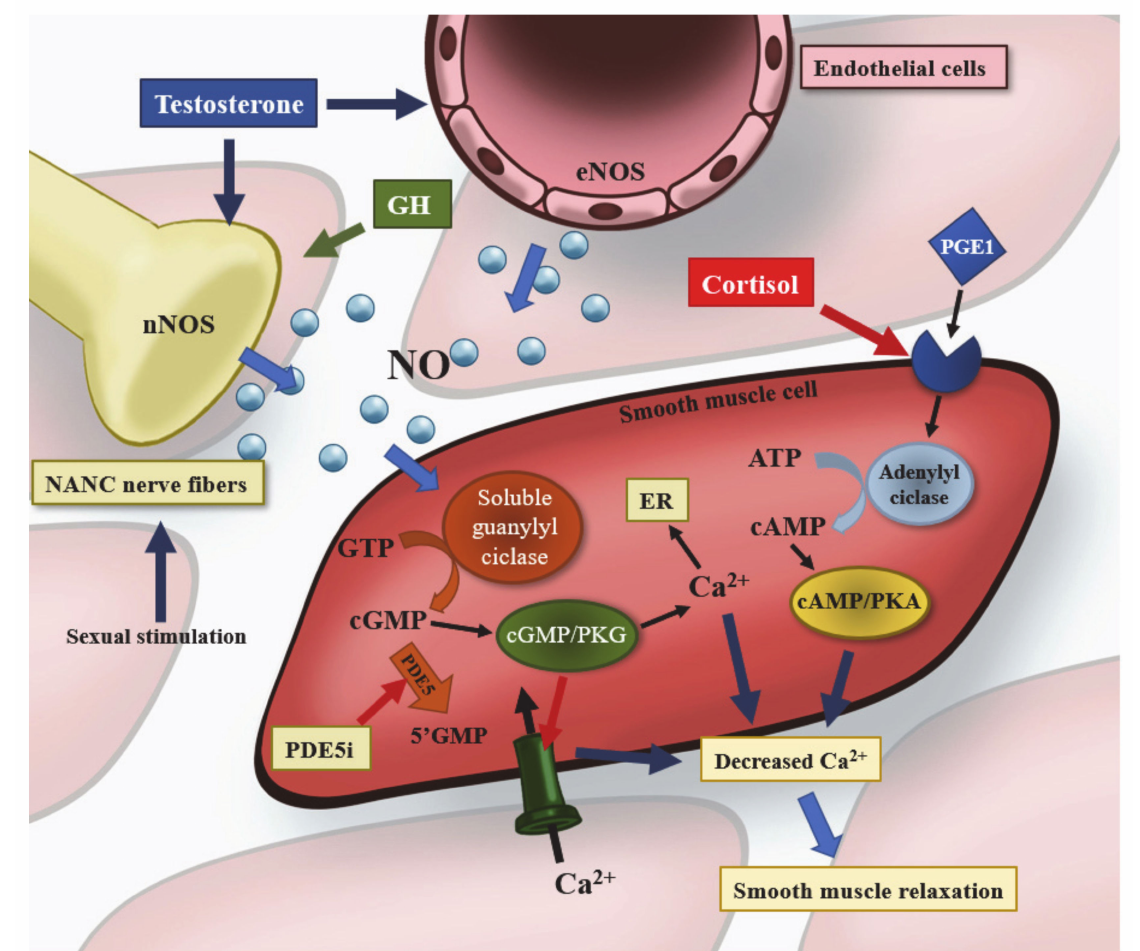
Figure 1. Mechanism of penile erection and hormonal interactions. Nitric oxide (NO) is produced by the enzyme NO synthase (NOS), which is located inside nonadrenergic noncholinergic (NANC) nerves (nNOS) and endothelial cells (eNOS). Sexual stimulation triggers the release of NO by the NANC nerves, which is enhanced by growth hormone (GH) and testosterone. The latter also upregulates the activity of NOS in both nerves and endothelial cells. In penile smooth muscle cells, NO binds to soluble guanylyl ciclase to increase production of 3 (cid:48) ,5 (cid:48) -cyclic guanosine monophosphate (cGMP) from guanosine-5 (cid:48) -triphosphate (GTP), which activates protein kinase G (PKG) to form a complex cGMP/PKG, which in turn inhibits the entry of extracellular calcium and promotes the shift of intracellular calcium into the endoplasmic reticulum (ER). Decreased calcium concentration leads to smooth muscle relaxation and, consequently, dilatation of the cavernous arteries and penile erection. Activity of cGMP/PKG is physiologically limited by the enzyme phosphodiesterase 5 (PDE5), which is the target of PDE5 inhibitor drugs (PDE5i), the first line of treatment for erectile dysfunction (ED). Prostaglandin 1 (PGE1), which is administered through intracavernosal injections for the treatment of ED, binds a G-protein-coupled receptor that stimulates adenylyl cyclase activity, which promotes the production of cyclic adenosine monophosphate (cAMP) from adenosine triphosphate (ATP). As for cGMP, cAMP activates a protein kinase (protein kinase A—PKA) and the complex cAMP/PKA reduces intracellular calcium levels and causes smooth muscle relaxation. High serum cortisol levels inhibit the response to intracavernosal injection of smooth muscle relaxants via an unknown